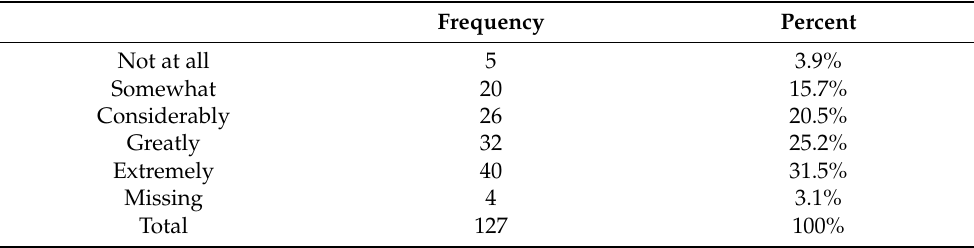
Table 5. The possibility of leaving the current job for another which offers more benefits.